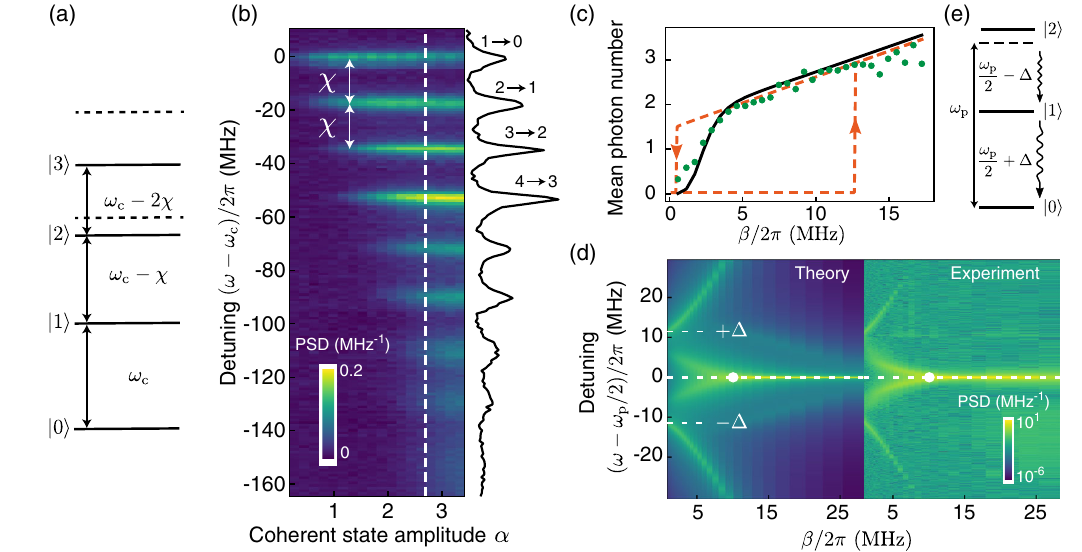
FIG. 2. (a) Energy-level diagram for the Kerr nonlinear resonator with each additional photon reducing the transition frequency by χ . (b) Transient PSD measurements for coherent states with different amplitudes α . The curve plotted on the right is the PSD corresponding to α indicated by the white dashed line. (c) Mean photon number h ˆ n i at a steady state versus the amplitude of the parametric driving at Δ = 2 π ¼ 25 . 3 MHz. The quantum prediction (solid line) agrees well with the experimental data. The classical model predicts two thresholds and hysteretic behavior (dashed line), corresponding to transitions between the monostable, tristable, and bistable regimes of the KPO [15]. (d) Steady-state PSD (logarithmic scale) for different driving amplitudes at Δ = 2 π ¼ 11 . 2 MHz. The spectrum goes from a double-peaked shape at small β to a single narrow peak in the self-oscillation regime, passing through a multipeaked spectrum at intermediate values of β . The white dot indicates the approximate onset of self-oscillation. The spacing between the two peaks in the weak drive limit is 2 Δ , as explained by the two-photon emission process shown in diagram (e).